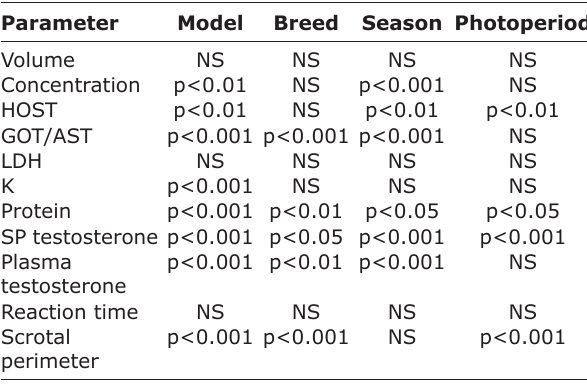
Table-1: Statistical significance in the factorial model of each of the factors that might affect semen and SP characteristics, and plasma testosterone concentrations, reaction time to artificial vagina, and scrotal perimeter of MG and P bucks maintained under natural or artificial (2 months long days -16 h light, 2 months short days - 8 h light) photoperiod throughout the year.